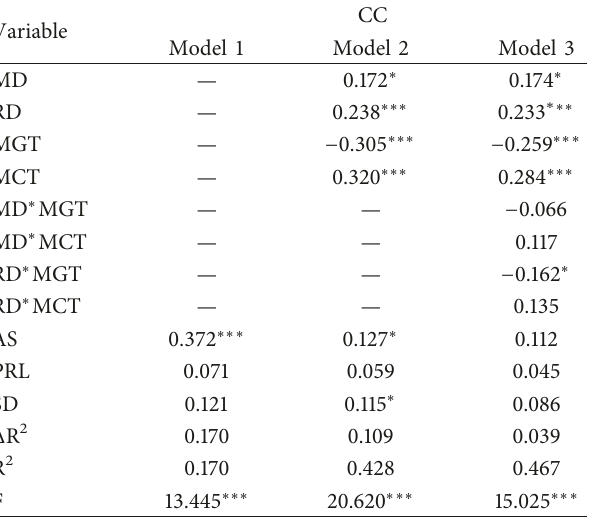
a Diagonal for variable AVE; b square root AVE; c diagonal external variable correlation coefficient. Table 5: Hierarchical regression analysis.